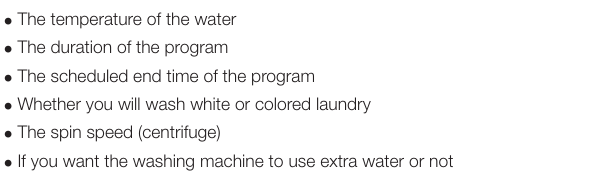
TABLE 2 | Overview of the six setting options that participants could